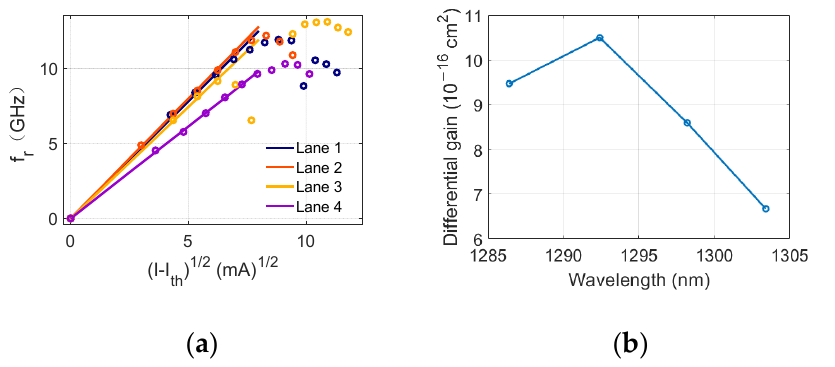
Figure 6. ( a ) The relationship between the relaxation oscillation frequency f r and the square root of the bias current above the threshold, where the solid dots and lines are the experimental data and fitting results, respectively. ( b ) The relationship between the values of four-channel differential gain and lasing wavelengths.